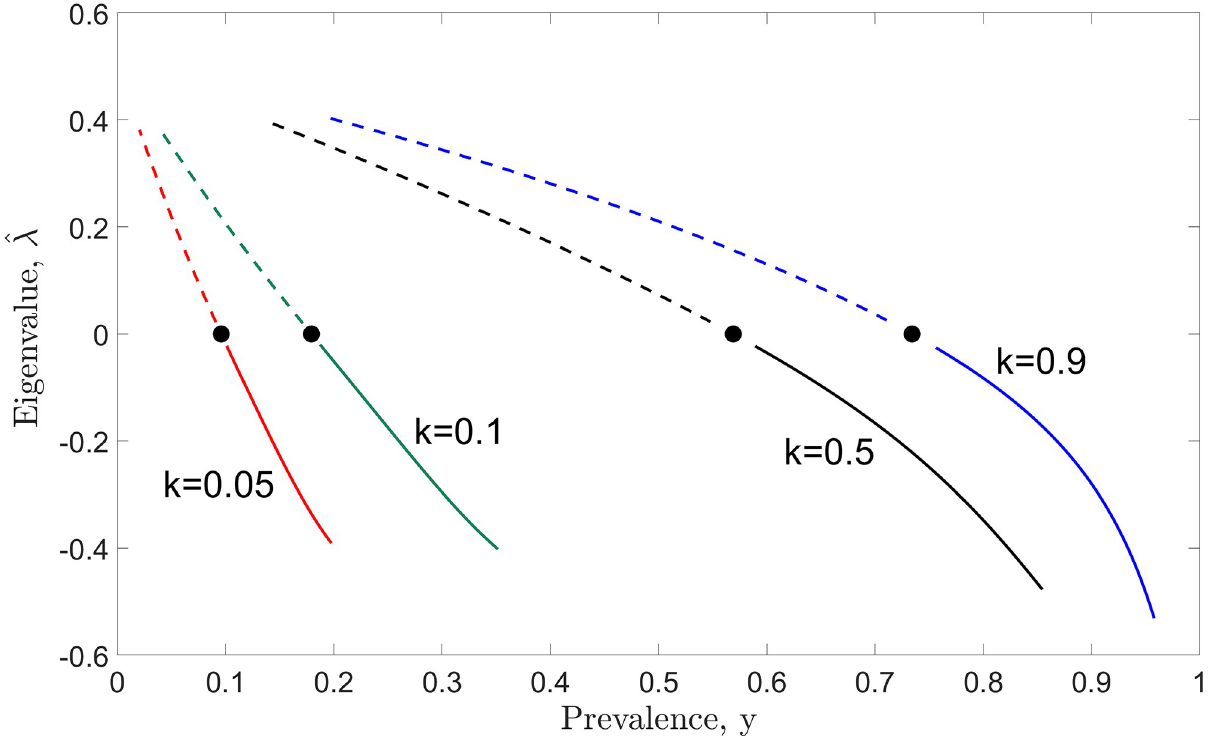
Fig 3. The relationship between the eigenvalue (6) and the endemic equilibrium of the model (5) is demonstrated by varying k values (corresponding to 0 � R 0 � 5). Linearization is one of the key methods employed in assessing stability, and it can be applied to determine the local stability of a model governed by ordinary differential equations. By definition [37], an equilibrium point is locally asymptotically stable if all eigenvalues have negative real parts, whereas it is unstable if at least one eigenvalue has positive real part. A local bifurcation occurs whenever the real part of an eigenvalue passes through